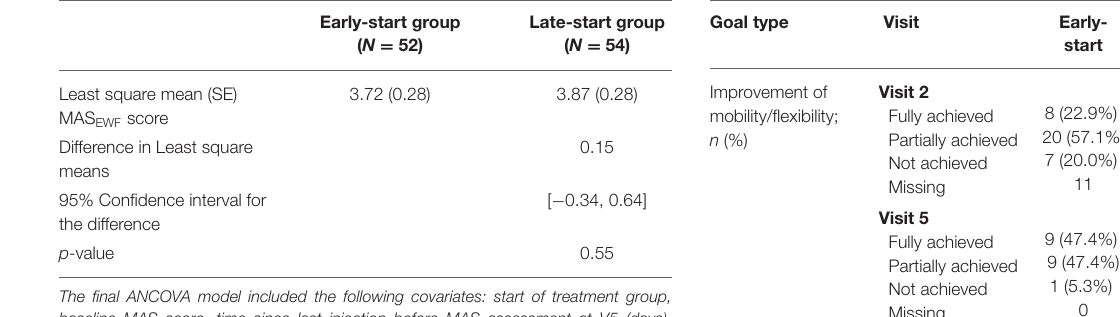
TABLE 3 | Primary ANCOVA analysis. TABLE 4 | Goal